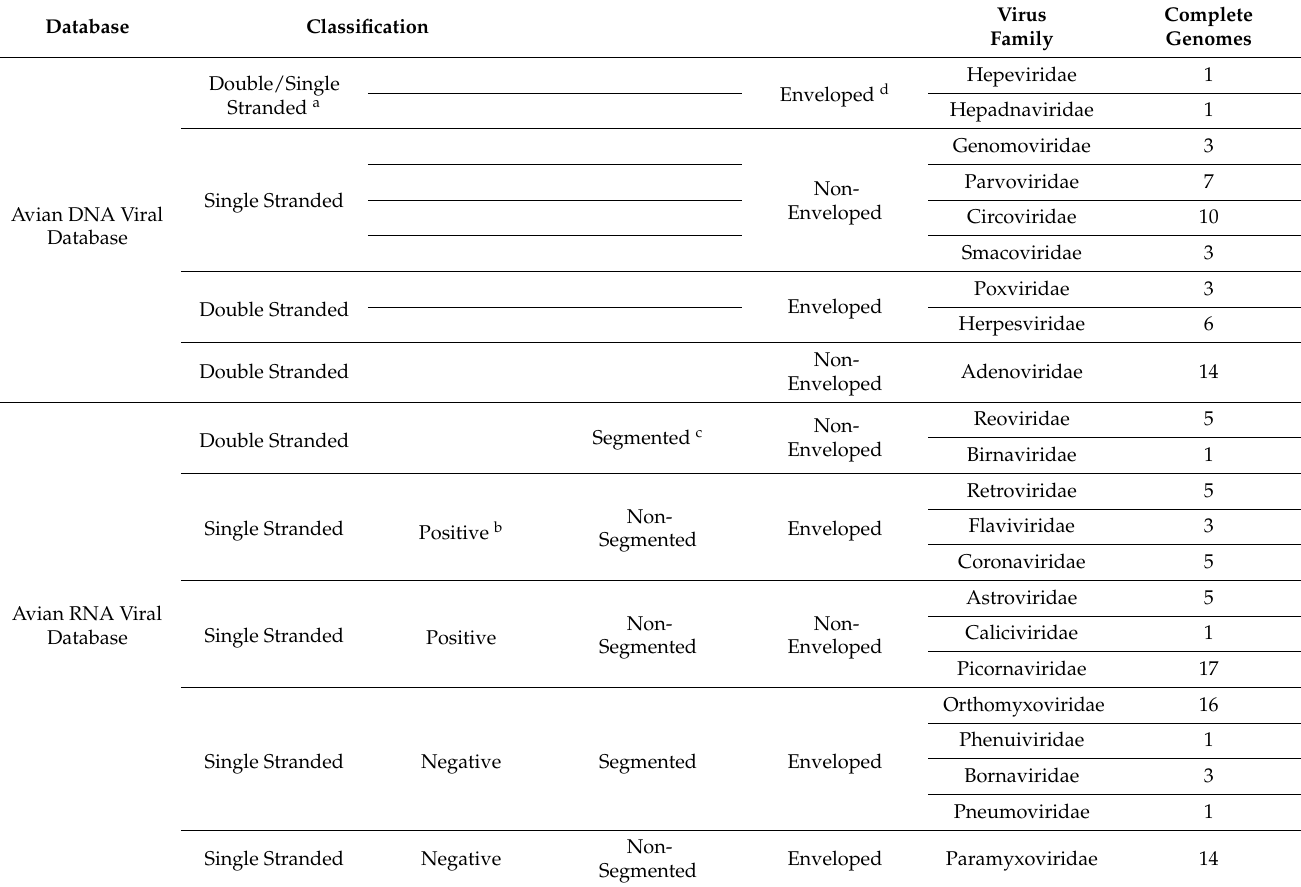
Table 1. Avian specific viral genome database